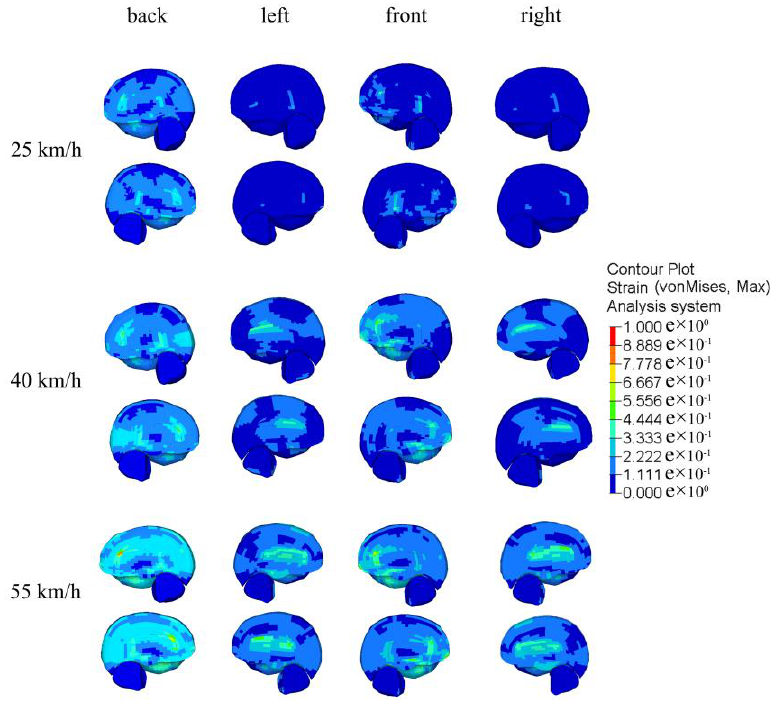
Figure 8. Parasagittal view of brain strain at different collision parameters.